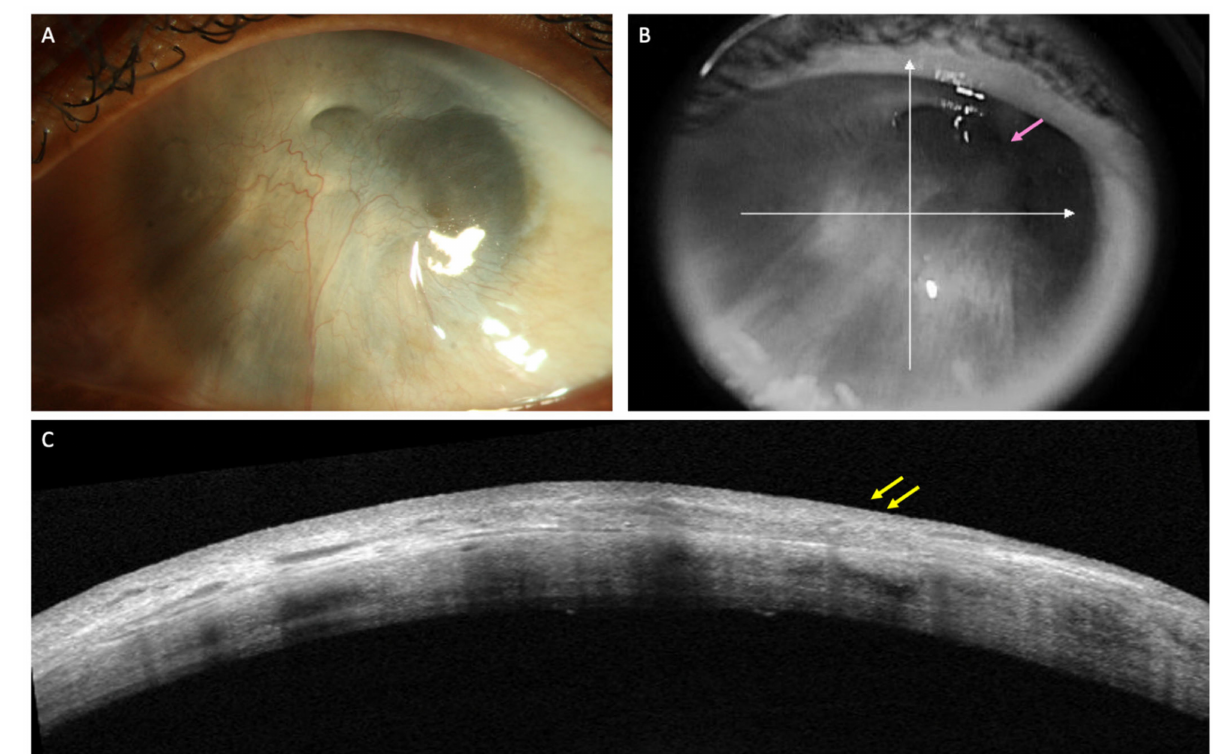
Figure 2. ( A – C ) Clinical images of the left eye of a patient with limbal stem cell deficiency (LSCD) due to chronic sequelae of ocular chemical burns. ( A ) Slit lamp image depicting total limbal stem cell deficiency with a thick fibrotic pannus covering the visual axis. ( B ) Details of the anterior chamber can be hazily visualized in the superotemporal quadrant (pink arrow) in the infrared image of optical coherence tomography (AS-OCT) scan. ( C ) AS-OCT line scan showing the hyperreflective pannus (yellow arrows) with sufficient corneal stromal thickness to permit pannus